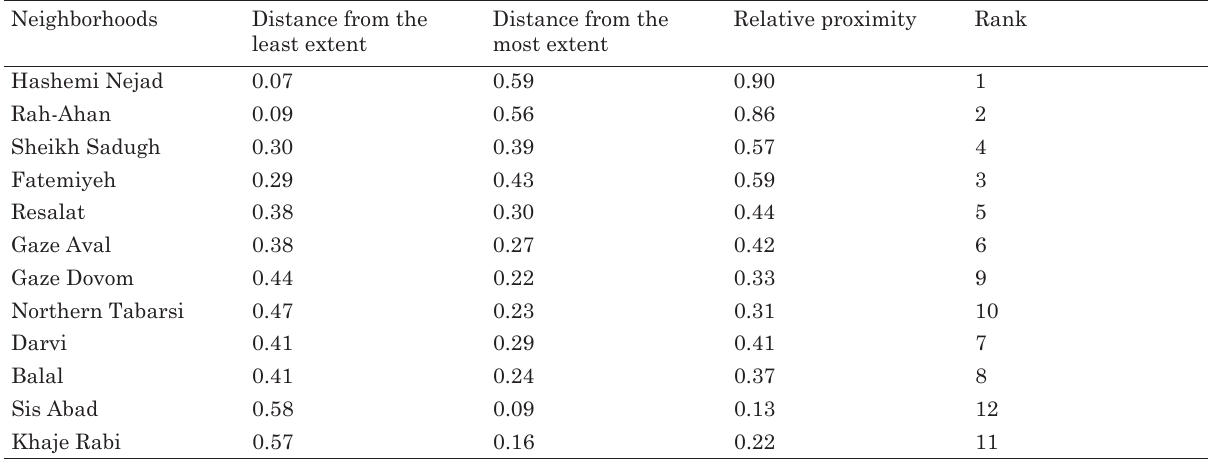
Table 4. Rating and determining of final development level neighborhoods with TOPSIS Neighborhoods Distance from the Distance from the Relative proximity least extent most extent Hashemi